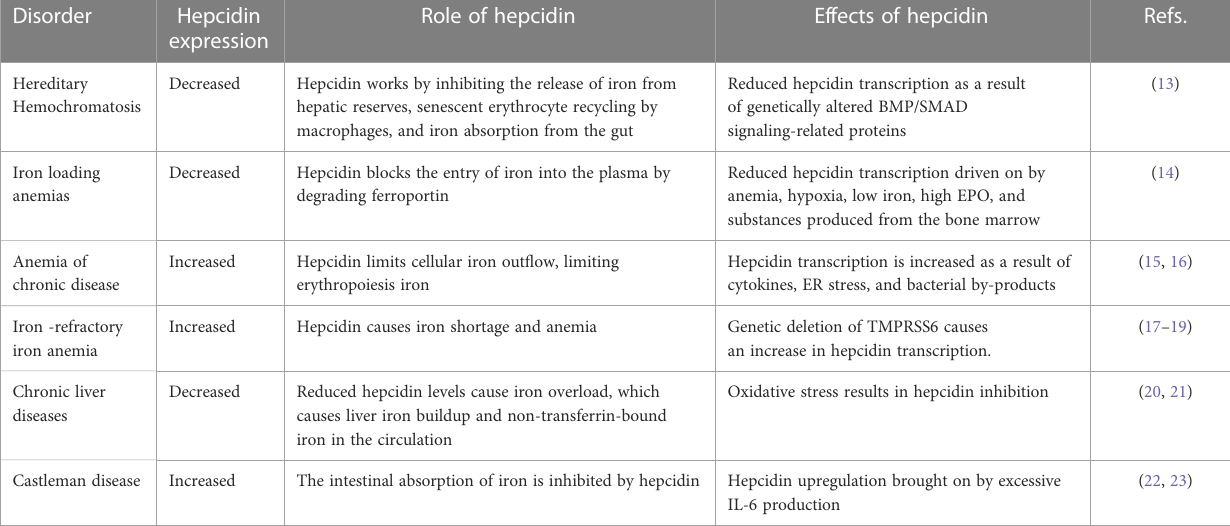
TABLE 1 Effect of hepcidin on iron metabolism and related